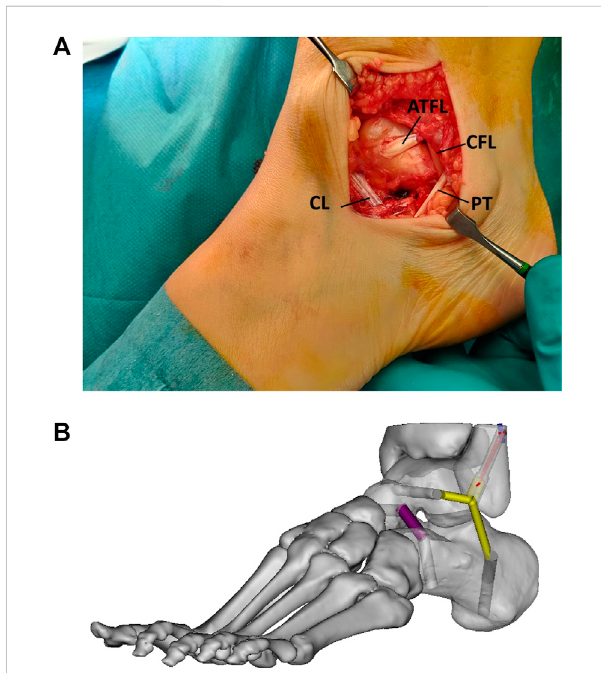
FIGURE 8 Combined ATFL, CFL and CL reconstruction. (A) . Intraoperative superolateral view with reconstructed cervical ligament (CL), reconstructed ATFL (ATFL) and reconstructed CFL (CFL) running behind the peroneal tendons (PT) (B) . Image with tunnel positioning. Sinus tarsi view (Figure 4 in Foot and Ankle Surg 2022 June. 10.1016/j.fas. 2022.06.006, no permission